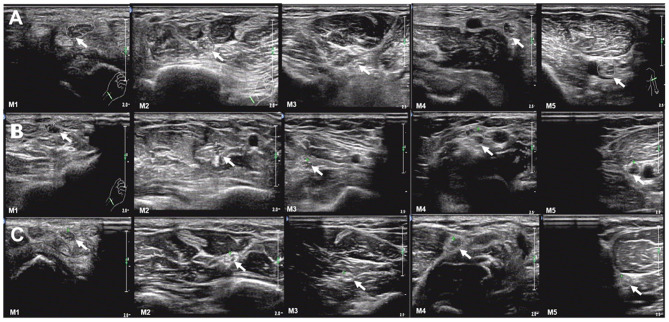
Examples of ultrasound cross-sections showing measurements of cross-sectional area of median nerves in M1-5 between the three groups. (A) Homogeneous enlargement was observed at sites M1-5 of a TTR-FAP patient. (B) Segmental enlargement was observed at sites M1-5 of median nerve in a CIDP patient. (C) The normal CSAs at sites M1-5 of a healthy control.